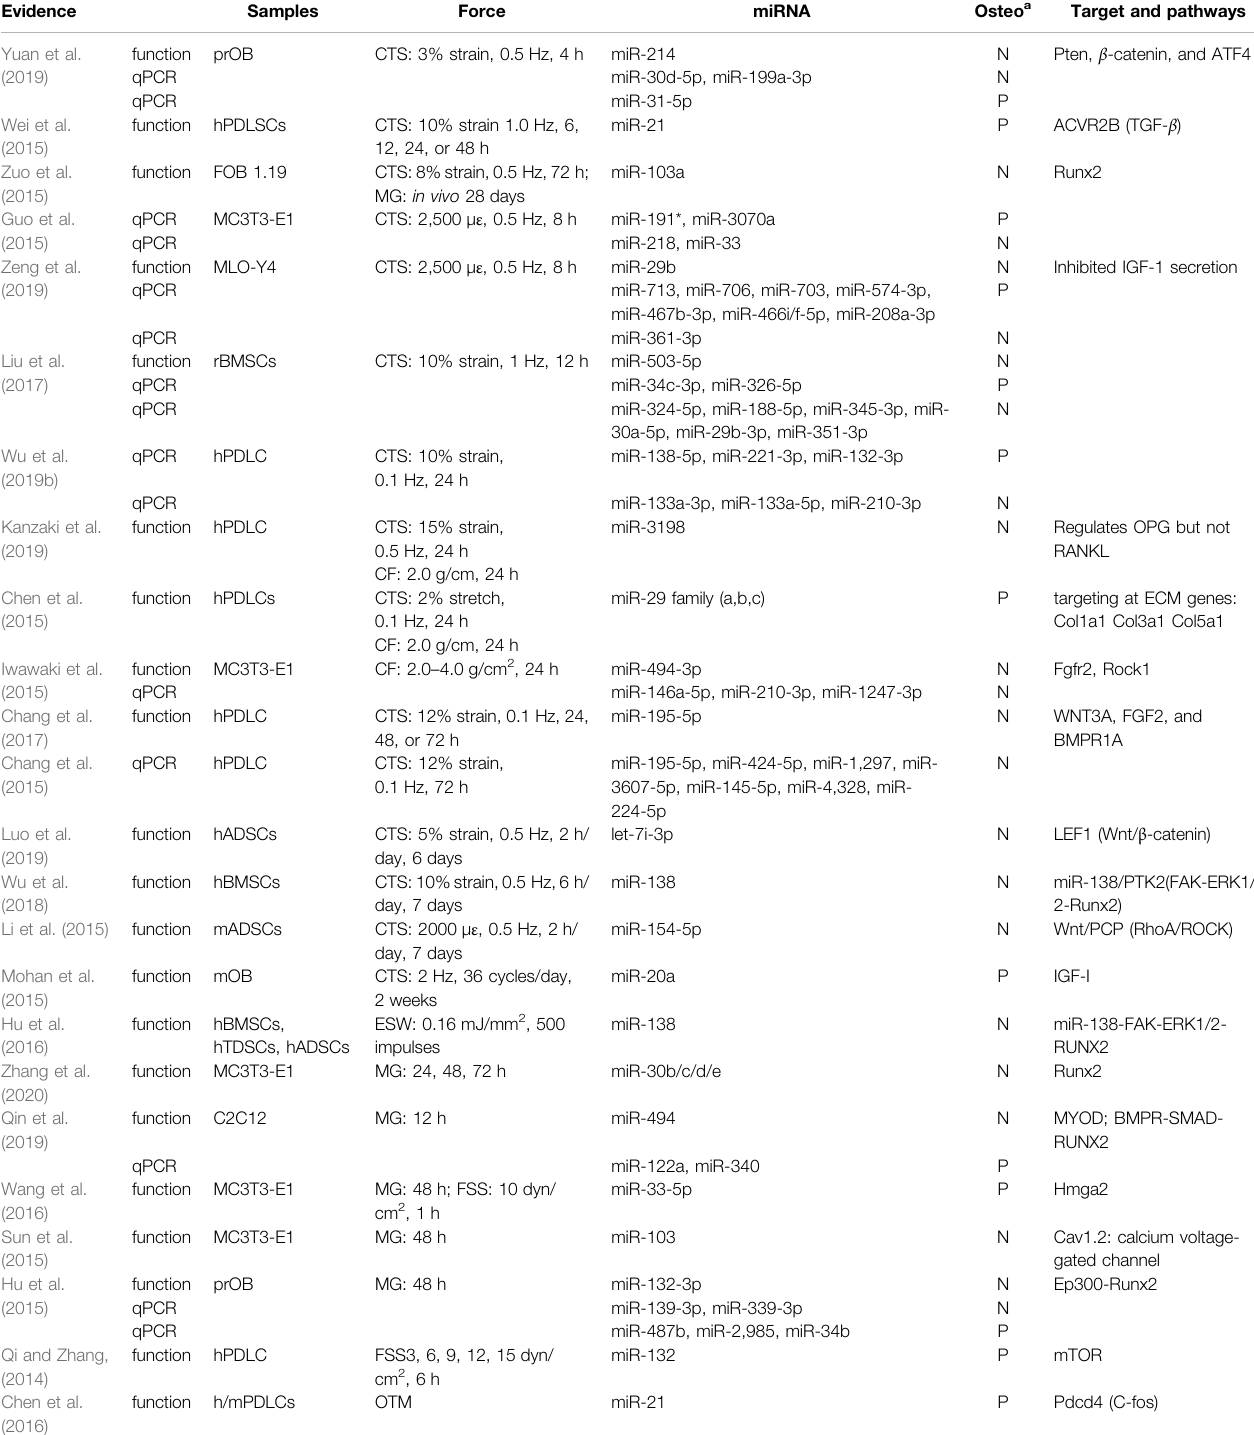
a Osteogenesis: N, negative; P, positive; CTS, cyclic tensile strain; CF, compressive force; MG, microgravity; OTM, orthodontic tooth movement; FSS, fl uid shear strain; ESW, extracorporealshockwave;rBMSCs/hBMSCs,rat/humanbonemarrow-derivedstemcells;hADSCs,humanadiposetissue-derivedstemcells;h/mPDLSCs,human/mouseperiodontal ligament stem cells; hPDLC, human periodontal ligament cells; m/prOB, mouse/primary rat